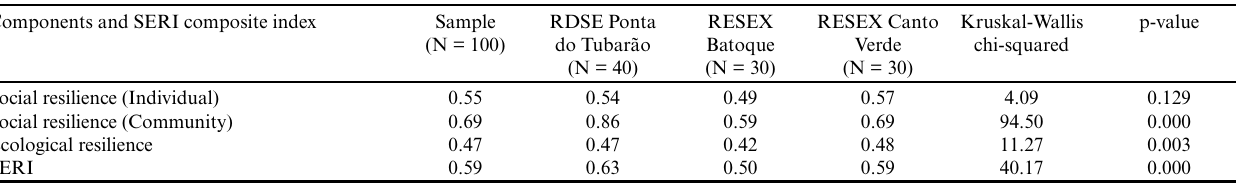
Table 3 . Average values for the social-ecological resilience index (SERI) and its components in the three marine protected areas (MPAs) analyzed: RDSE Ponta do Tubarão, RESEX Batoque, and RESEX Canto Verde. The sample column shows the average values among all fishers sampled, followed by MPAs average values, and the last two columns show the results of the Kruskal-Wallis statistical test.